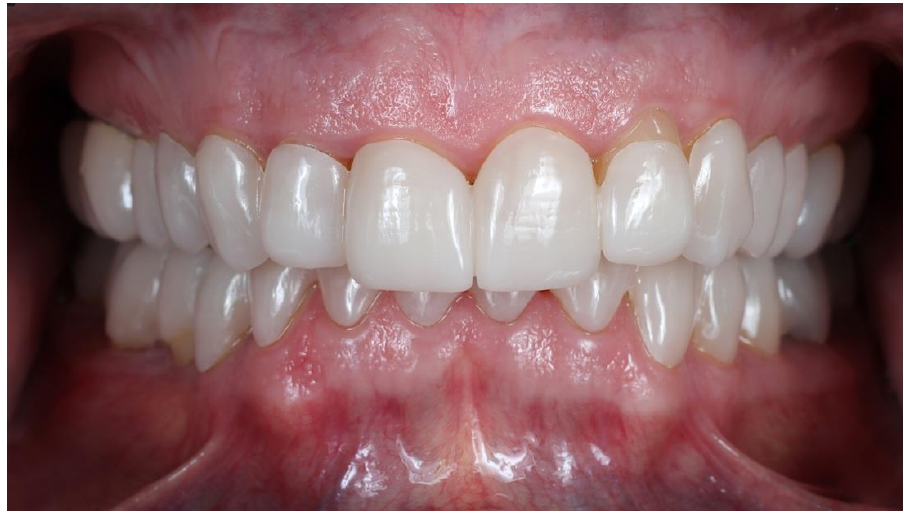
Figure 6. Case 2—Intraoral view of a patient wearing DEFS, made of polycarbonate.